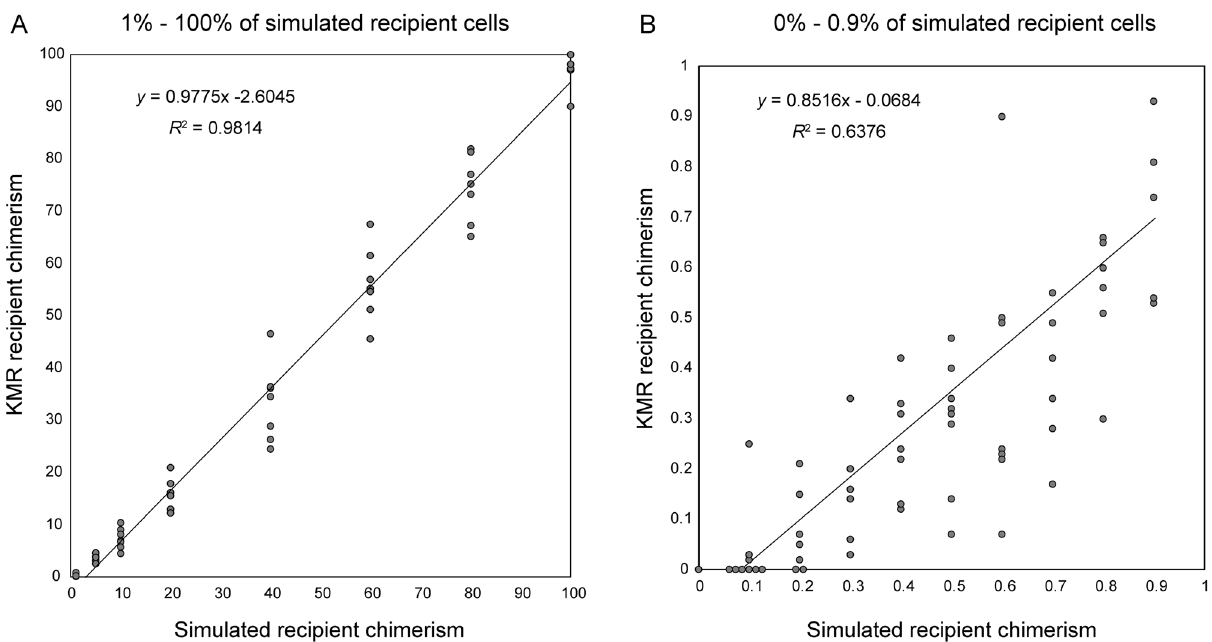
Figure 3. Correlation of KMR and simulated chimerism in virtual samples. Chimerism was evaluated by KMRtrack in virtual samples containing mixtures of DNA from 2 individuals. DNA mixtures with ( A ) 1%, 5%, 10%, 20%, 40%, 60%, 80%, and 100%, or ( B ) 0%, 0.1%, 0.2%, 0.3%, 0.4%, 0.5%, 0.6%, 0.7%, 0.8%, and 0.9%, of simulated recipient cells were prepared according to DNA concentrations. The recipient chimerisms of these DNA mixtures were evaluated by KMRtrack using the 7 markers with highest informativity to distinguish Japanese donor/recipient